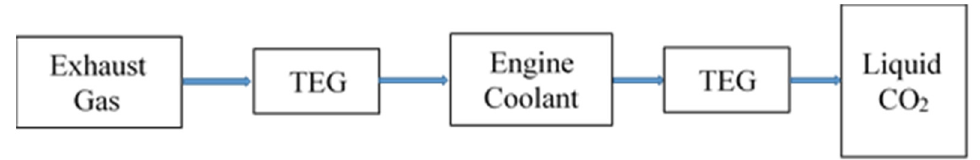
Figure 4. CCS Equipment Flow Figure 4: CCS Equipment Flow Diagram.